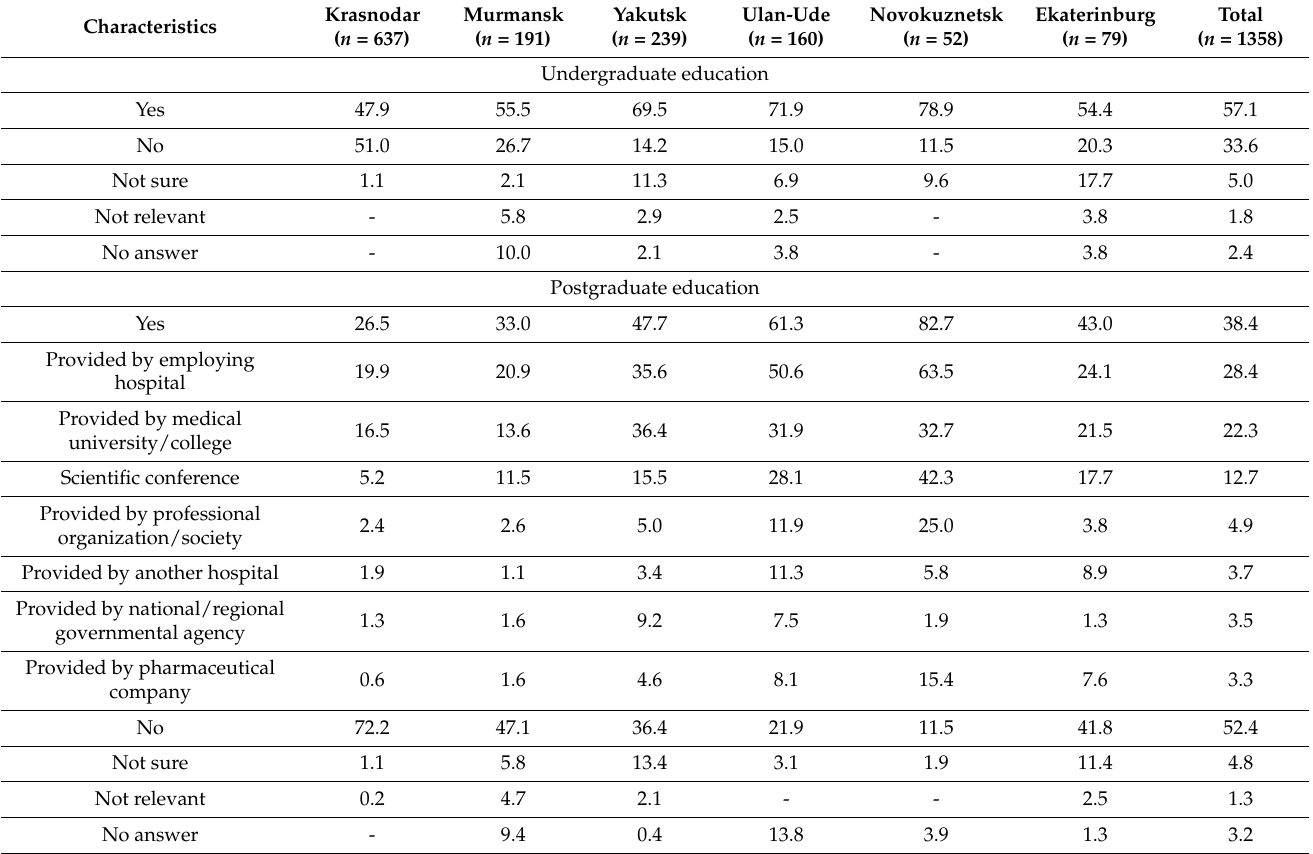
Table 3. Personal education and training in antimicrobial stewardship,